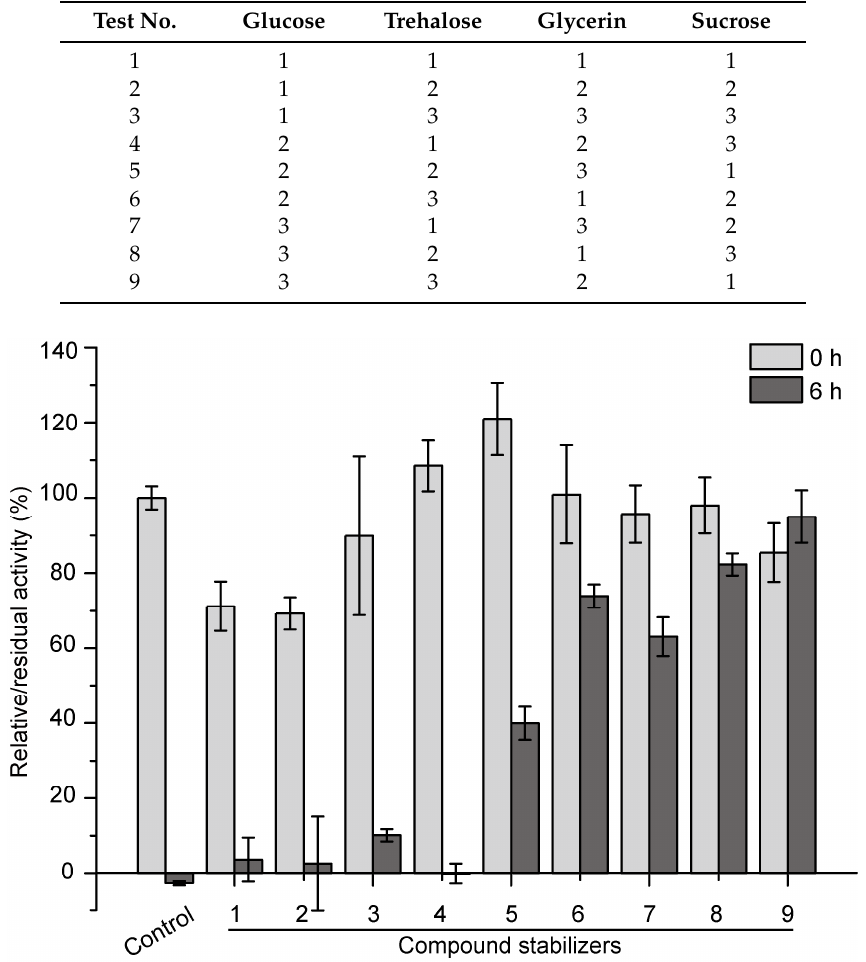
Table 2. Orthogonal test design for compound stabilizers.